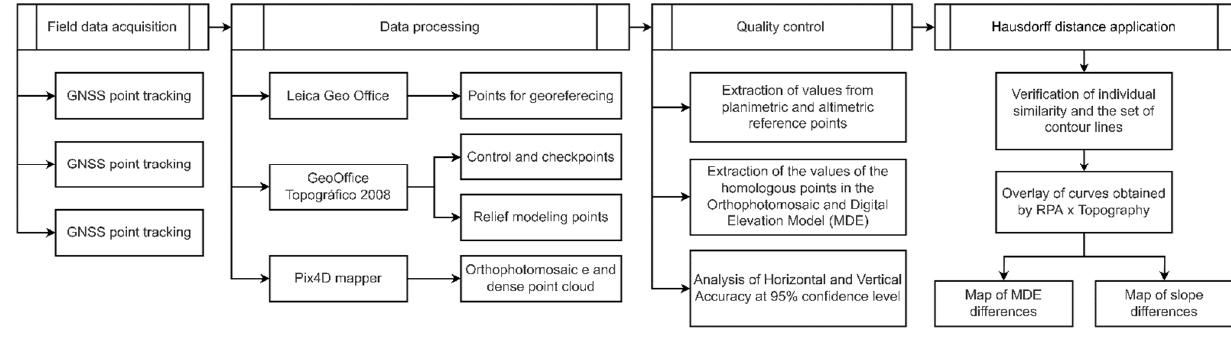
Figure 3. Flowchart for data acquisition and analysis.